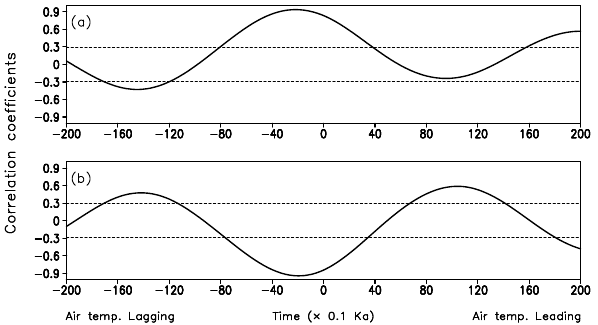
Fig. 12 . Leading and lagging correlation coefficients (solid lines) between the Fig. 12. Leading and lagging correlation coefficients (solid lines) simulated Guliya August–September SAT and (a) the North Atlantic (30°W–30°E, between the simulated Guliya August–September SAT and (a) the North Atlantic (30 ◦ W–30 ◦ E, 60 ◦ –75 ◦ N) August–September SST 60°–75°N) August–September SST and (b) the Guliya August–September and (b) the Guliya August–September precipitation. The horizontal precipitation. The horizontal short-dashed lines represent the 95% confidence short-dashed lines represent the 95% confidence level.